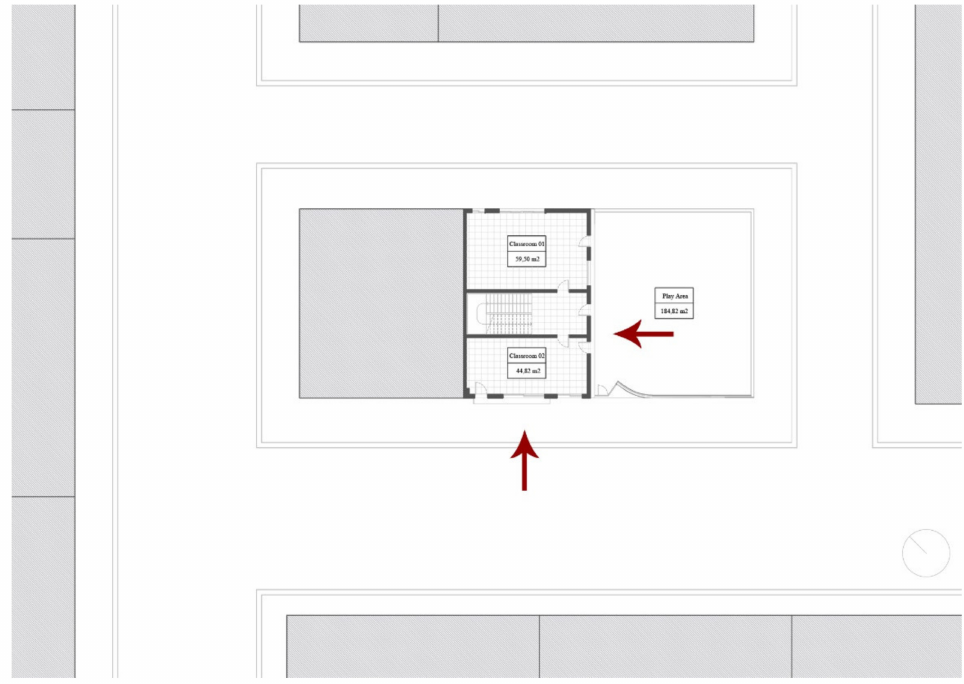
Figure 3. Floor elevation: existing building and surroundings—ground